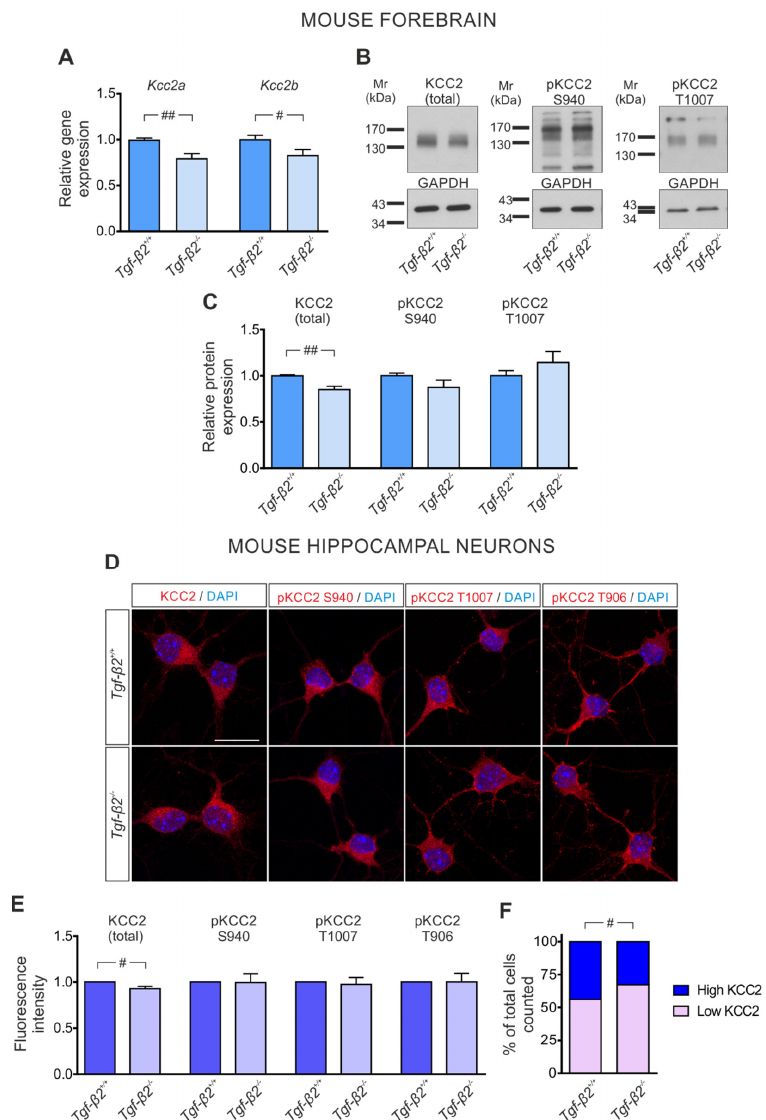
Figure 3. TGF- β 2-dependent regulation of KCC2 in the mouse forebrain. ( A ) Quantitative RT-PCR analysis for Kcc2a and Kcc2b on cDNA from forebrain at embryonic day ( E ) 17.5 of wildtype ( Tgf- β 2 +/+ ) and Tgf- β 2 − / − mice ( # p < 0.05 and ## p < 0.01 for significant decrease using two-tailed unpaired Student’s t -test, n = 7 for Tgf- β 2 +/+ and n = 6 for mutant). ( B ) Immunoblot analysis for total KCC2 and for phosphorylated (p)KCC2 at S940 or T1007 in homogenates from forebrain tissue of Tgf- β 2 +/+ and Tgf- β 2 − / − mice. ( C ) Quantification of immunoblots ( ## p < 0.01 for significant decrease after densitometric analysis of the signal ratio protein KCC2: GAPDH and two-tailed unpaired Student’s t -test, n = 6–7 for wildtype and n = 6 for mutant). The data are shown as mean ± S.E.M., relative to the mean of wildtype littermates. The blots are representative for four different litters. A total of 30 µ g protein was loaded per lane. ( D ) Cellular localization of KCC2 (red) and phosphorylated (p)KCC2 at S940, T1007 or T906 in primary hippocampal neuronal cultures from Tgf- β 2 +/+ and Tgf- β 2 − / − by immunofluorescence and subsequent confocal microscopy. Scale bar: 20 µ m. ( E ) Quantification of labelling intensity ( # p < 0.05 for significant decrease in Tgf- β 2 − / − compared to wt using two-tailed unpaired Student’s t -test; ~ 400 cells were analyzed per genotype for total KCC2 and ~100–200 cells for (p)KCC2 labeling). ( F ) Distribution (%) of counted cells (~400 per genotype) expressing high or low KCC2 between Tgf- β 2 +/+ and Tgf- β 2 − / − ( # p < 0.05 for significant decrease of high KCC2-expressing cells in Tgf- β 2 − / − compared to Tgf- β 2 +/+